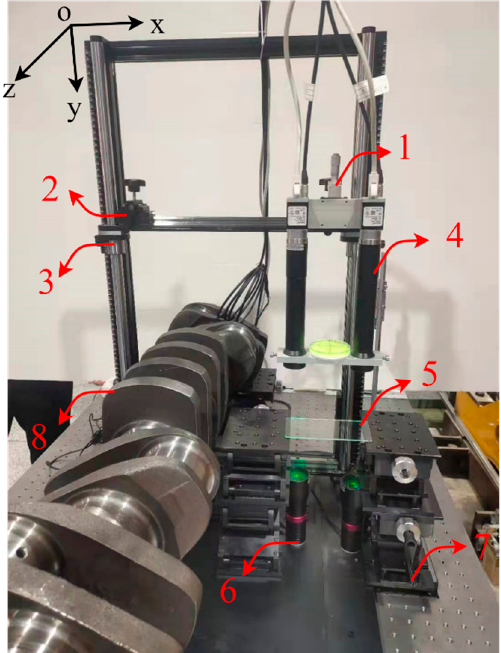
Figure 8. Measurement platform: (1) Adjustable device 1; (2) adjustable device 2; (3) adjustable device 3; (4) dual camera system; (5) calibration board; (6) parallel light sources; (7) adjustable device 4; (8) crankshaft.